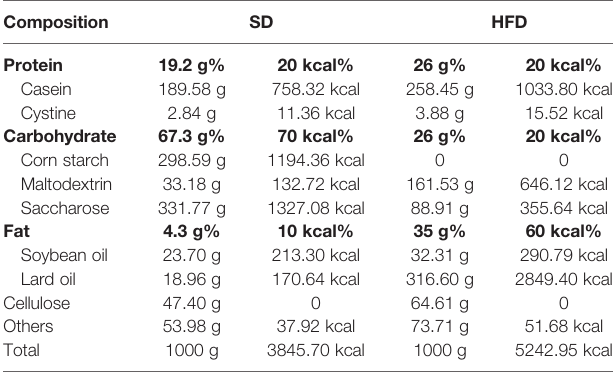
TABLE 1 | The composition of standard diet (SD) and high fat diet (HFD). Composition SD HFD